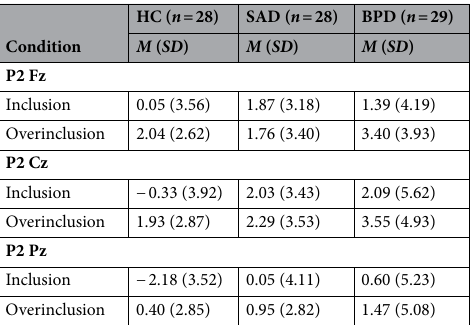
Table 1. Means and SDs of the P2 amplitude in social anxiety disorder, borderline personality disorder and healthy controls. HC healthy controls, SAD social anxiety disorder, BPD borderline personality disorder, Fz frontal, Cz central, Pz